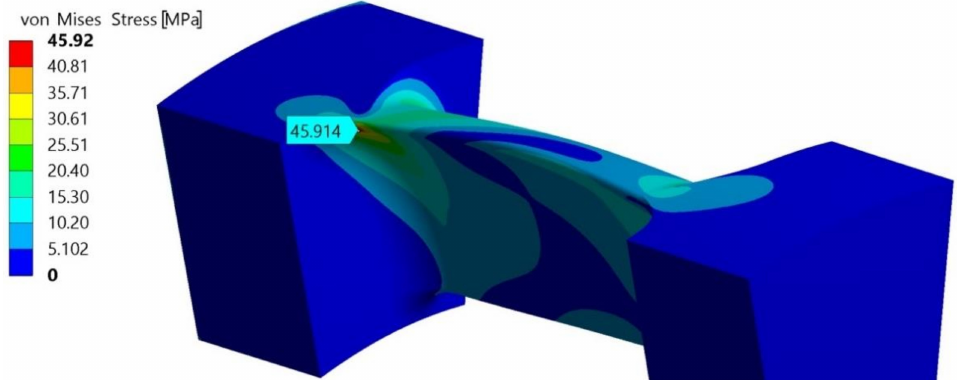
Figure 19. von Mises stress for single blade finite element method (FEM)